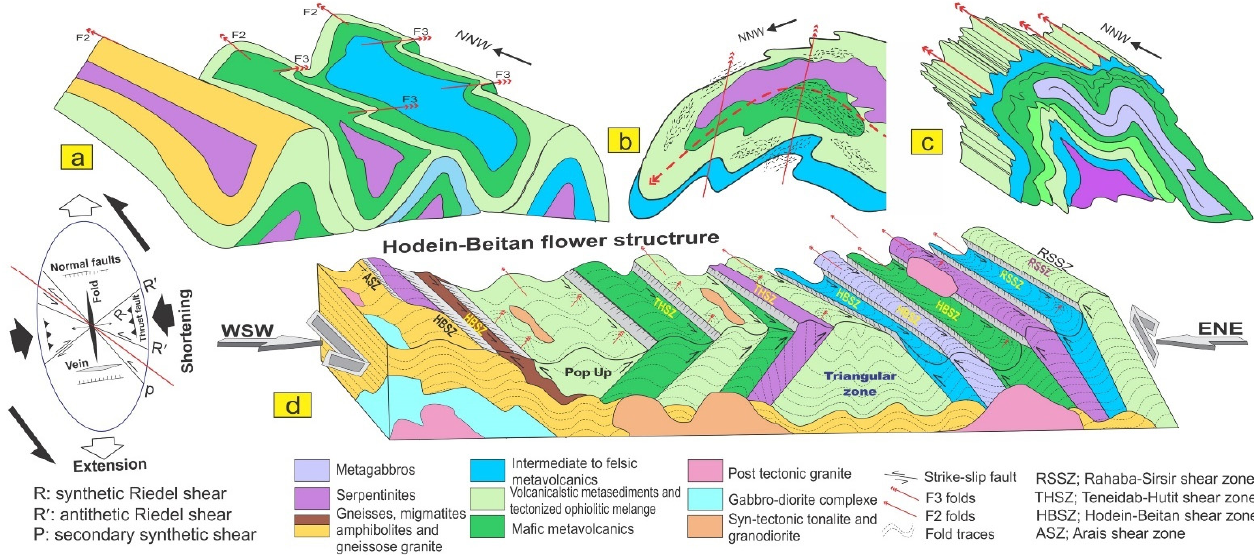
Figure 16. ( a – c ) F2 folds superimposed by the upright open F3 folds in the Wadi Hodein shear belt (Wadi Hodein, Wadi El Beida and Wadi Khashab areas). ( d ) Sketch block diagram illustrating the structural evolution of the Wadi Hodein shear belt.